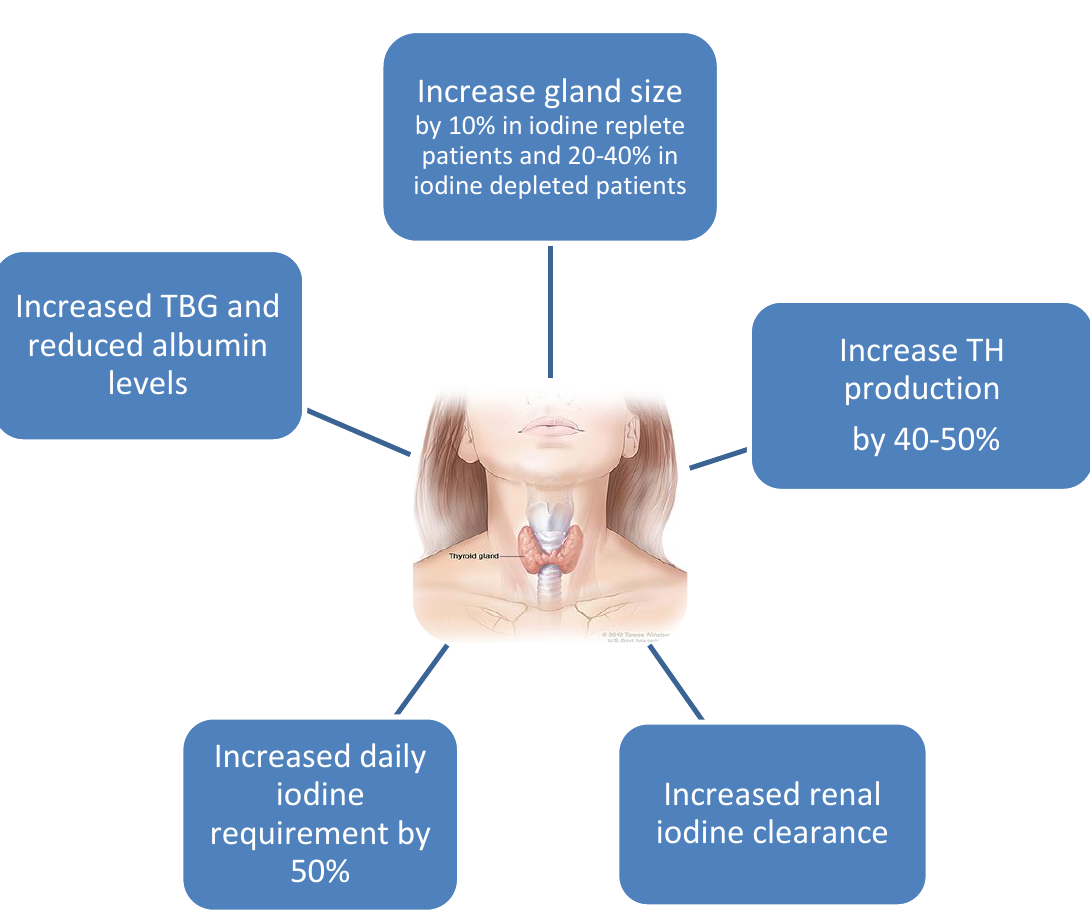
Figure 4.1. Pregnancy associated alterations in thyroid physiology TBG: thyroid binding globulin, TH: thyroid